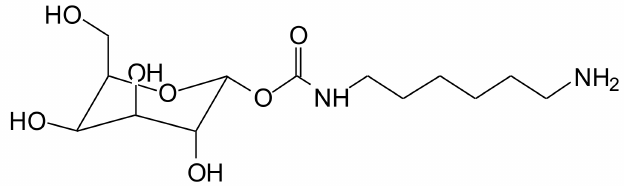
Figure 2. Urethane formed by reaction of monocarbonated glucose with hexamethylene diamine; 322 Da